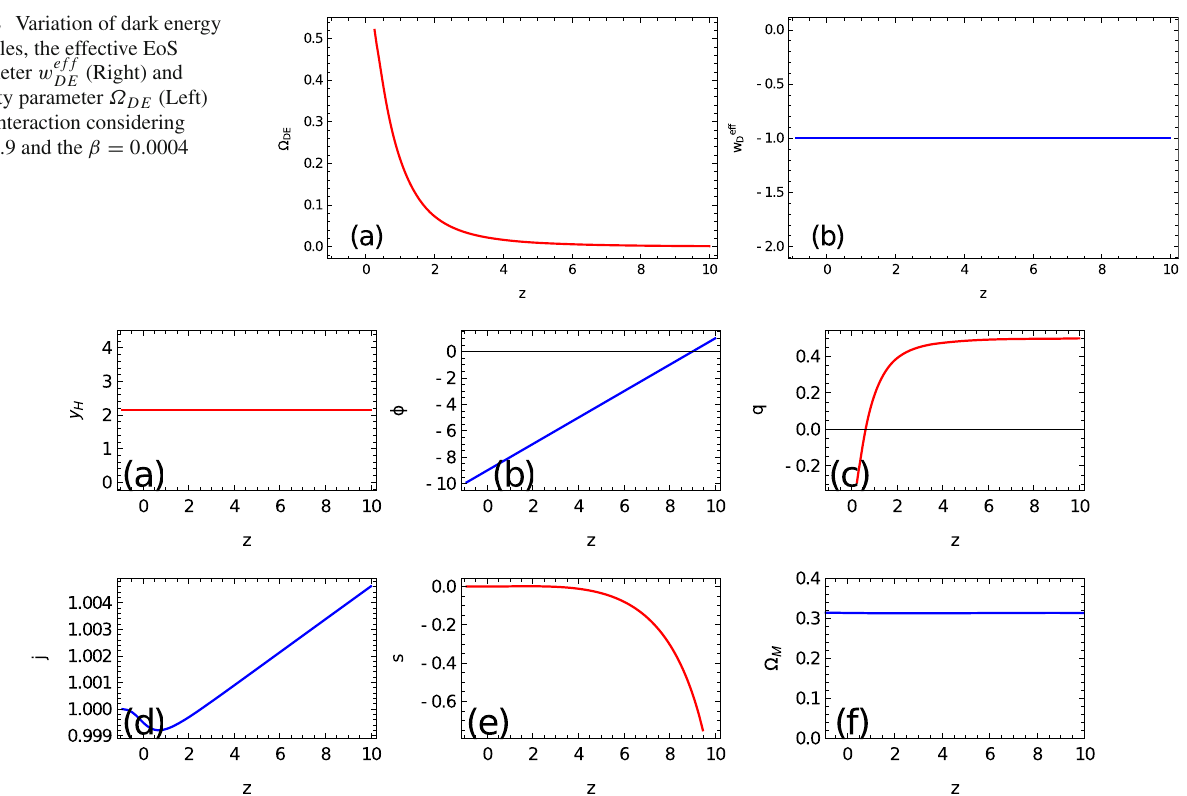
Fig. 3 Solutions for the statefinder parameter Ω H and scalar field φ over reduced Planck mass with interaction considering α = 0 . 9 and η = − 0 . 0006 in presence of a scalar field V (φ) . Cosmological parameters are also plotted as functions of redshift